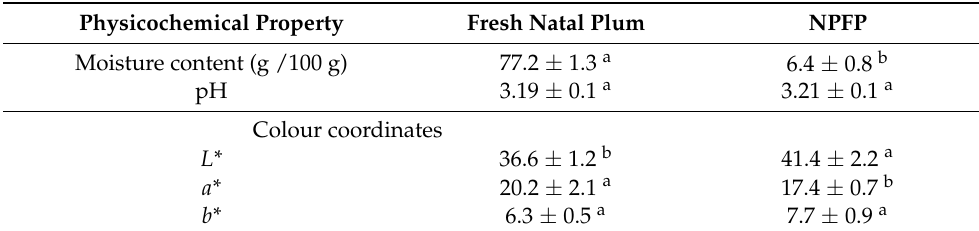
Table 1. Physicochemical characteristics of the fresh Natal plum and